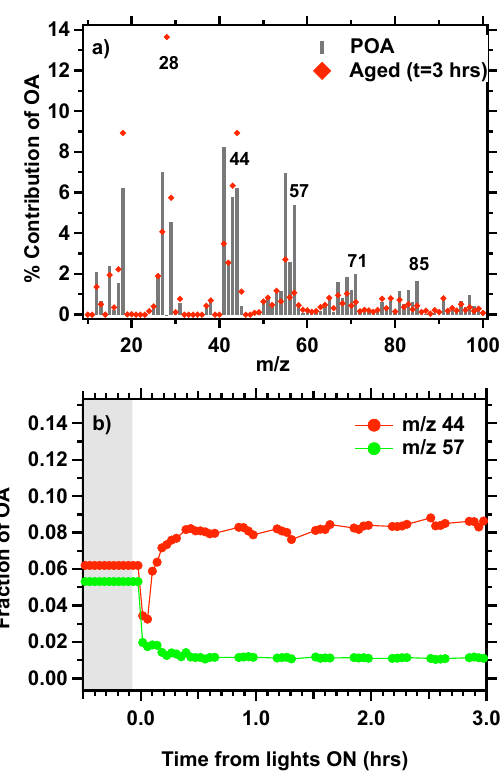
Fig. 7. (a) SOA mass measured at the end of the aging phase of the experiment. (b) Sum of single-ring aromatic compounds and sum of IVOC emissions as a function of load. Data are presented as a function of engine load. Single-ring aromatics include ben- zene, toluene, xylenes, ethyl benzene, styrene, ethyl toluene, and trimethylbenzenes. Sum of IVOCs includes speciated compounds and unresolved complex mixture (UCM) collected on Tenax sor- bent.